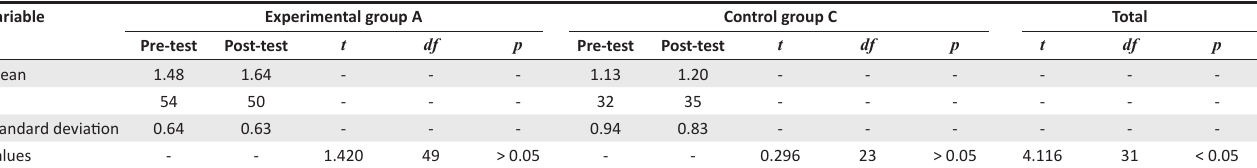
TABLE 1: Making predictions in isiXhosa.